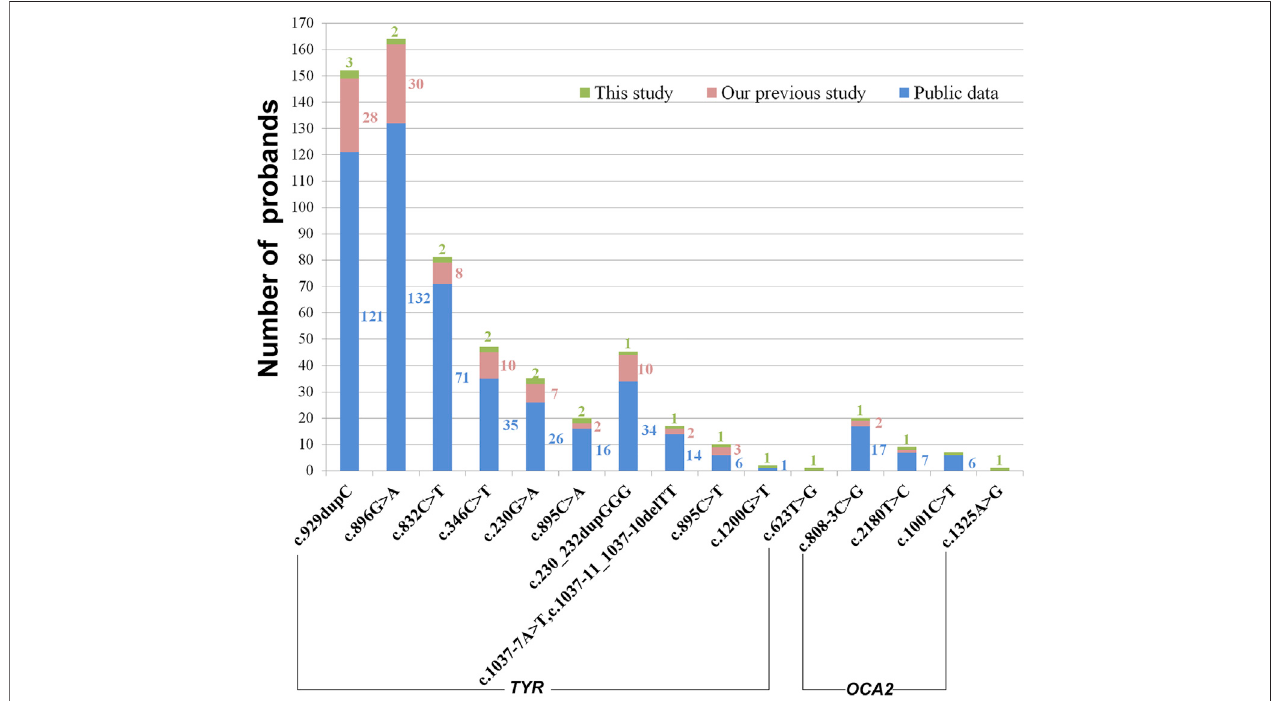
FIGURE 3 | Variant sharing on proband counts. The number of probands was in the same color as that of bars. Publicly available data were collected from the published literature about Chinese OCA cases.